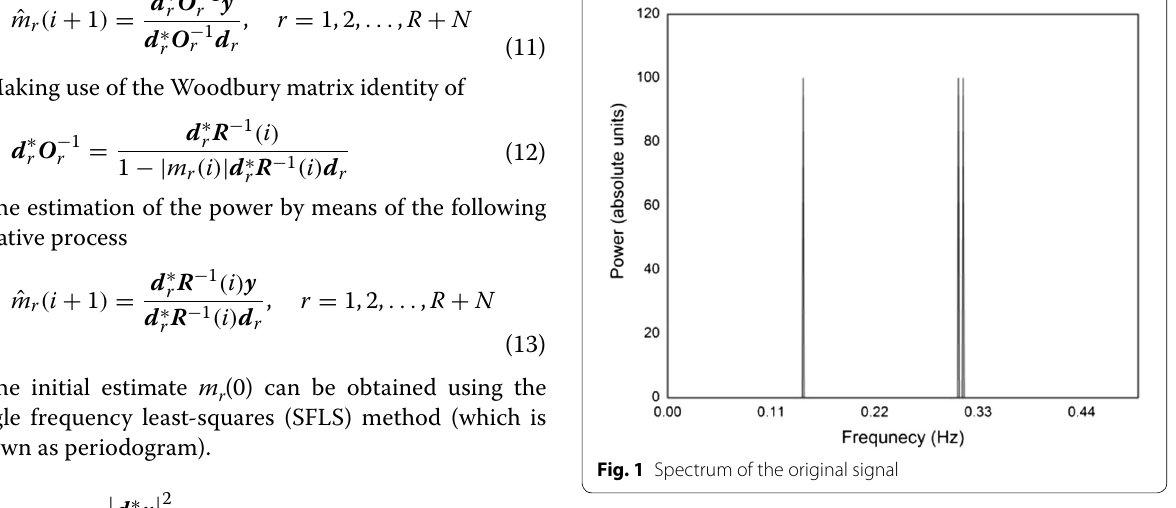
Fig. 2 Spectrum of the test signal for SNR